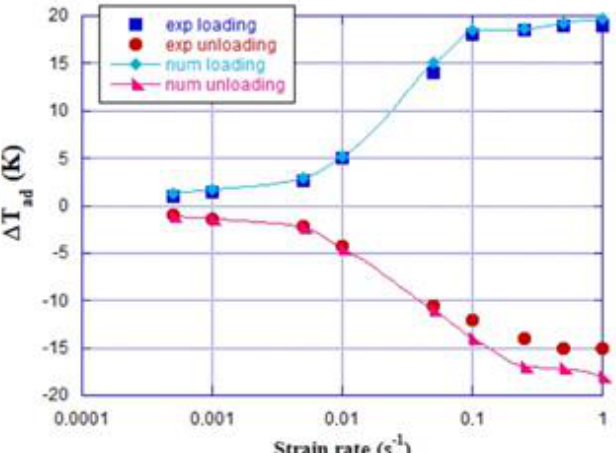
Figure 3. Experimental validation of the model. The adiabatic temperature change due to elastocaloric effect of a Ni 50.4 Ti 49.6 wire: comparison between numerical and experimental results vs. strain rate.